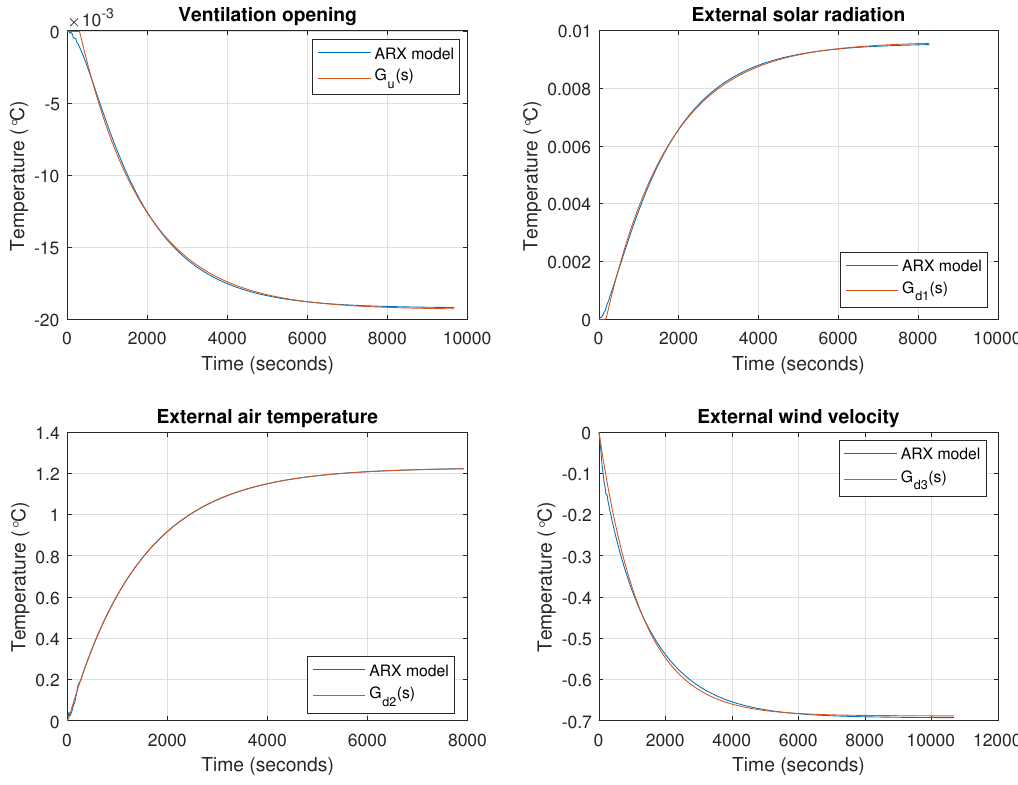
Figure 10. Unit step responses of the ARX model (for each input) compared against the transient responses of the transfer function